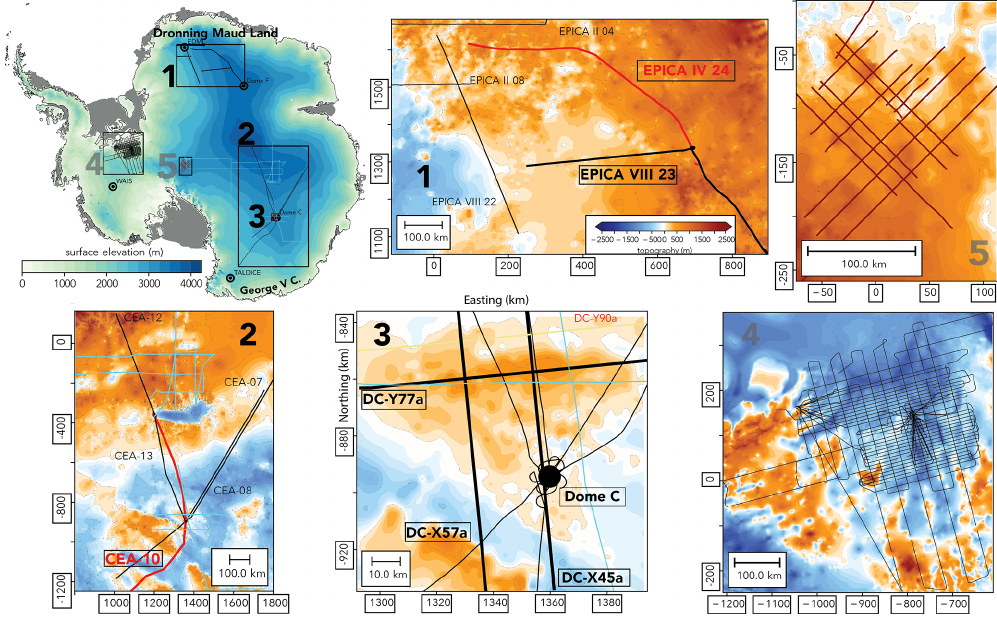
Figure 1. Antarctic surface (top left) and bedrock elevation from BedMachine Antarctica (Morlighem et al., 2020) overlain by radar transects with individual dated isochrones analysed in this study. The enlarged sections highlight regional clusters and their respective topographic settings. Clusters 1–3 are discussed in this study. The isochrone data are from cluster (1) – Winter et al. (2019); cluster (2) and (3) – Leysinger Vieli et al. (2011), Cavitte et al. (2016), Cavitte et al. (2020) and Winter et al. (2019); cluster (4) – Beem et al. (2020); and cluster (5) – Ashmore et al. (2020). Northing and easting are attained via cartographic transformation based on the WGS84 reference coordinate